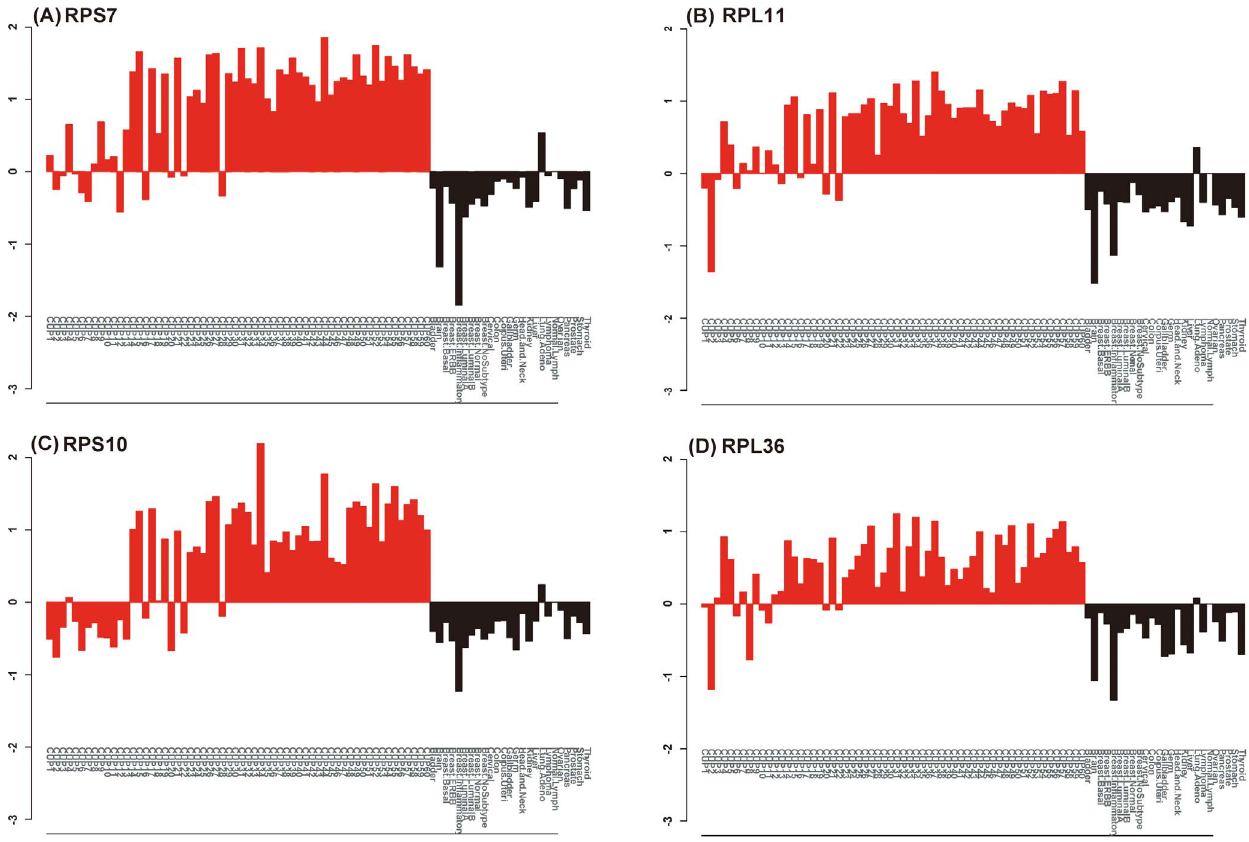
Figure 4. Relative expression levels for 4 ribosomal proteins. The relative expression levels of (A)RPS7, (B)RPL11, (C)RPS10, and (D)RPL36 were compared using individual CUP samples (n=60), the mean expression levels of known cancer types, and a normal lymph node samples (n=25). The asinh-transformed values for each gene were used for the calculations.